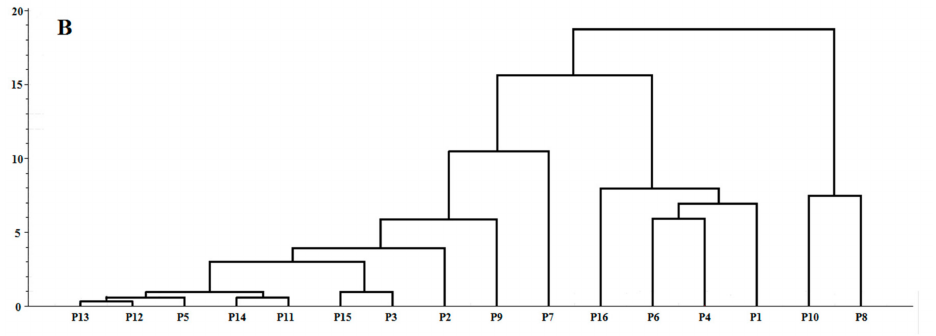
Figure 3. Hierarchical cluster analysis (HCA) dendrograms of: ( A ) 14 RXF samples; and ( B ) 16 PXF